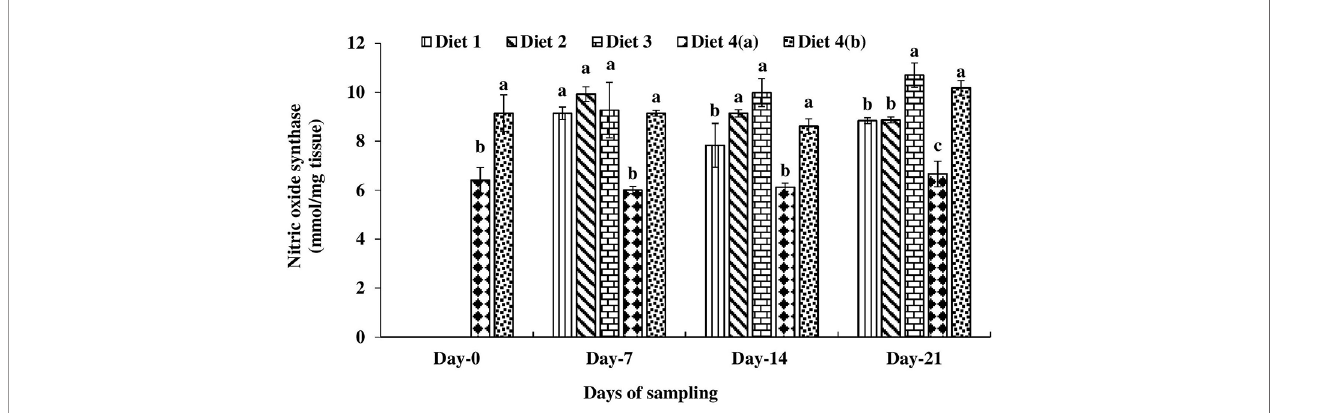
FIGURE 2 | Nitric oxide synthase level found in four different diets fed UV-B exposed and unexposed Catla catla . Bars with different superscripts (a-e) are signi fi cantly different (n